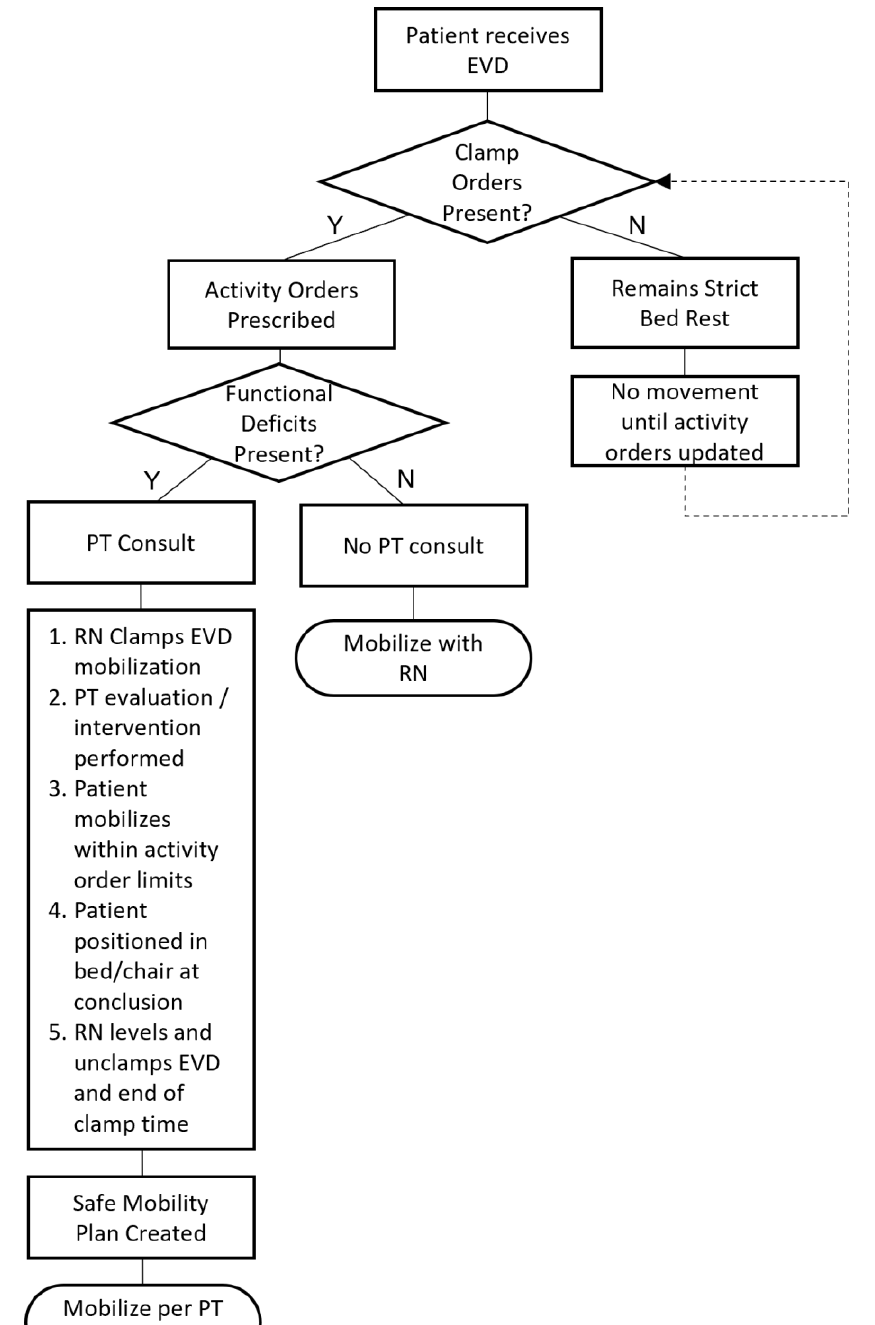
Figure 1. Registered Nurse (RN) and Therapy Protocol for the Mobilization for Children with an External Ventricular Drain (EVD).